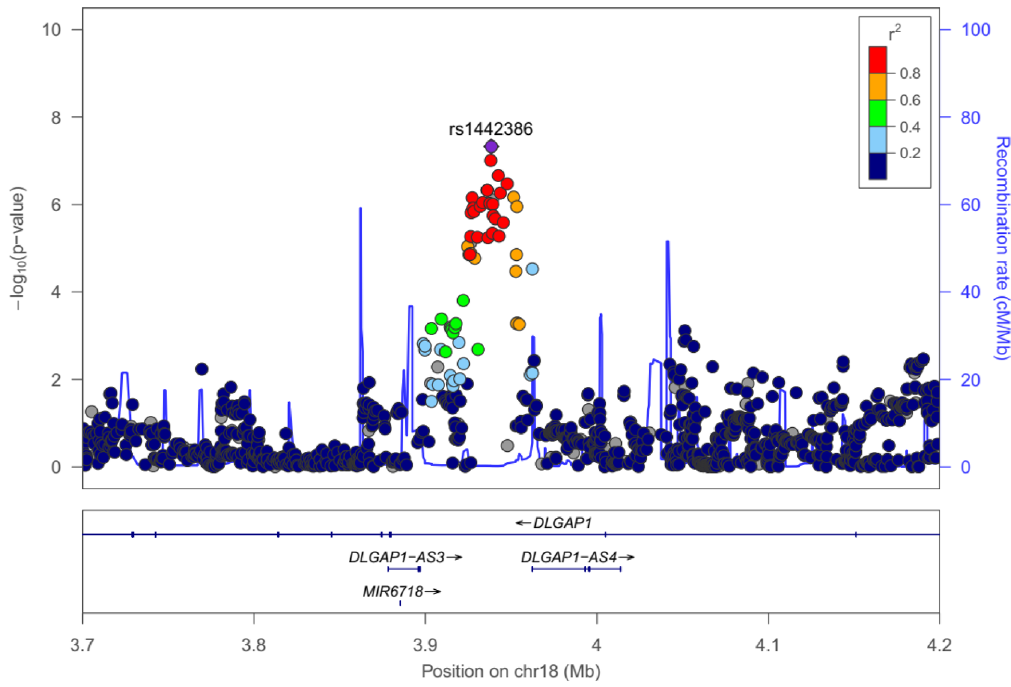
Figure 2. Regional association plots for locus significantly associated with resistant hypertension in Japanese population, on chromosome 18p11.3 ( DLGAP1 ). The regional association plot was generated from the association data of a genome-wide association study (GWAS) with LocusZoom. Purplish blue lines represent local recombination rates. SNPs are colored according to their linkage disequilibrium (measured by r 2 )